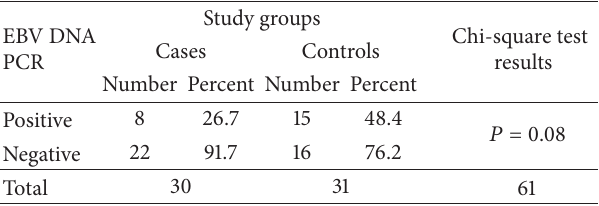
positive (239 bp or 256 bp bands) and samples 1 and 3 are negative. C+ and C − indicate positive and negative controls, respectively, and M represents the DNA marker. Table 1: Percentage distribution of PCR results from BLLF1 gene of EBV in 30 patients with macular amyloidosis and 31 melanocytic nevus samples among samples positive for beta-globin